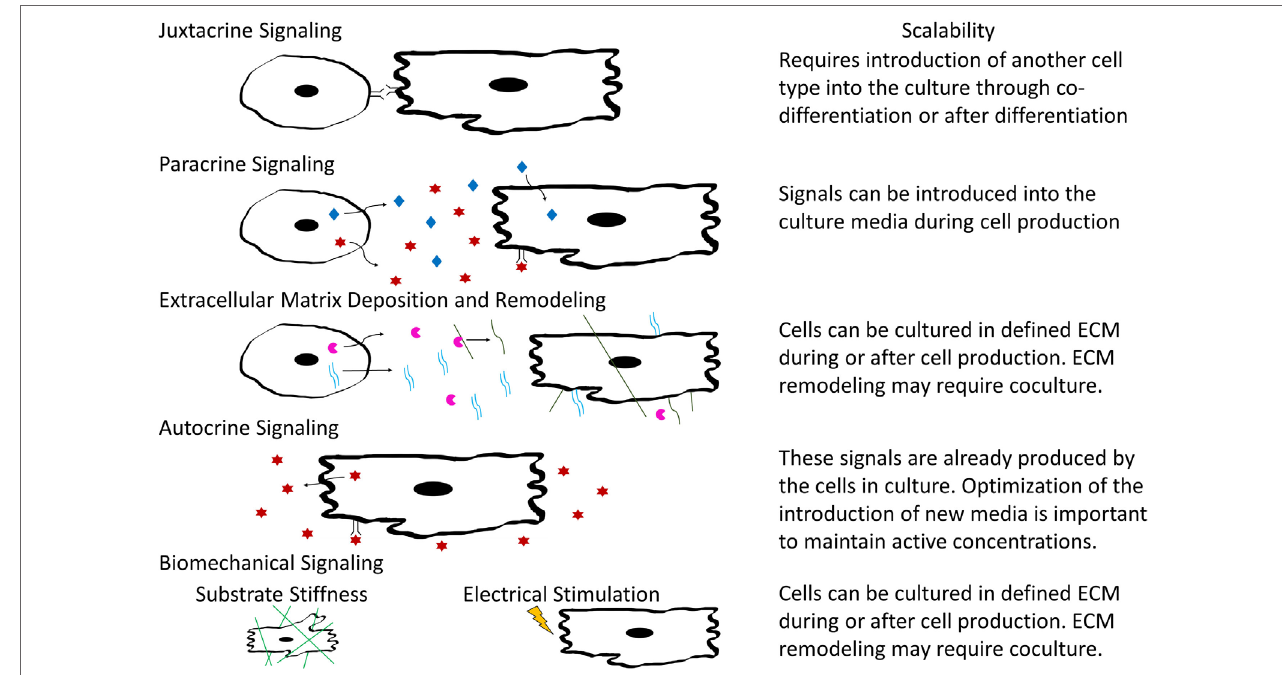
FiGURe 3 | Schematic illustrating types of intercellular interactions and their scalability for inclusion into large-scaling